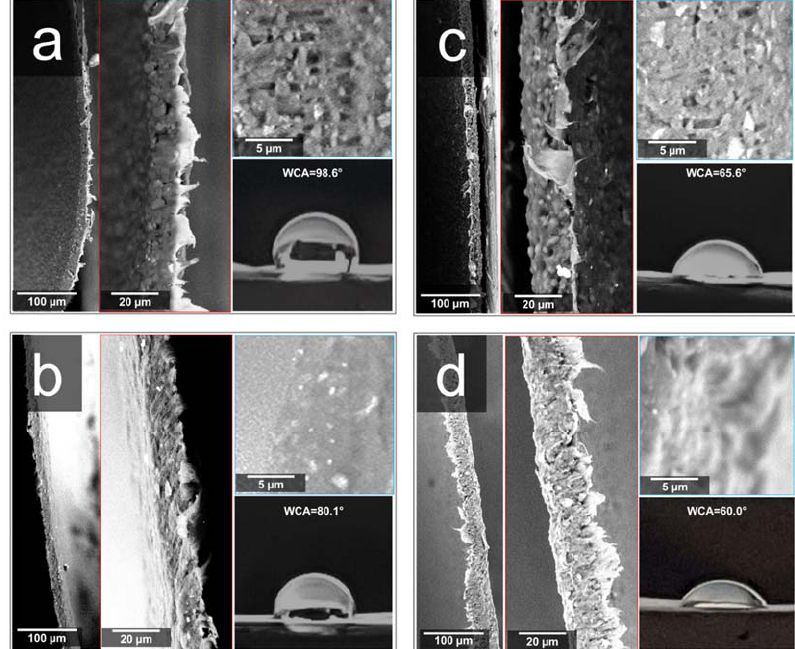
ff erent magnifications and water contact angles (WCAs) Figure 1. Cross ‐ sectional SEM micrographs at different magnifications and water contact angles Figure 1. Cross-sectional SEM micrographs at di of ( a ) BF; ( b ) BF-D; ( c ) BF-C; ( d )